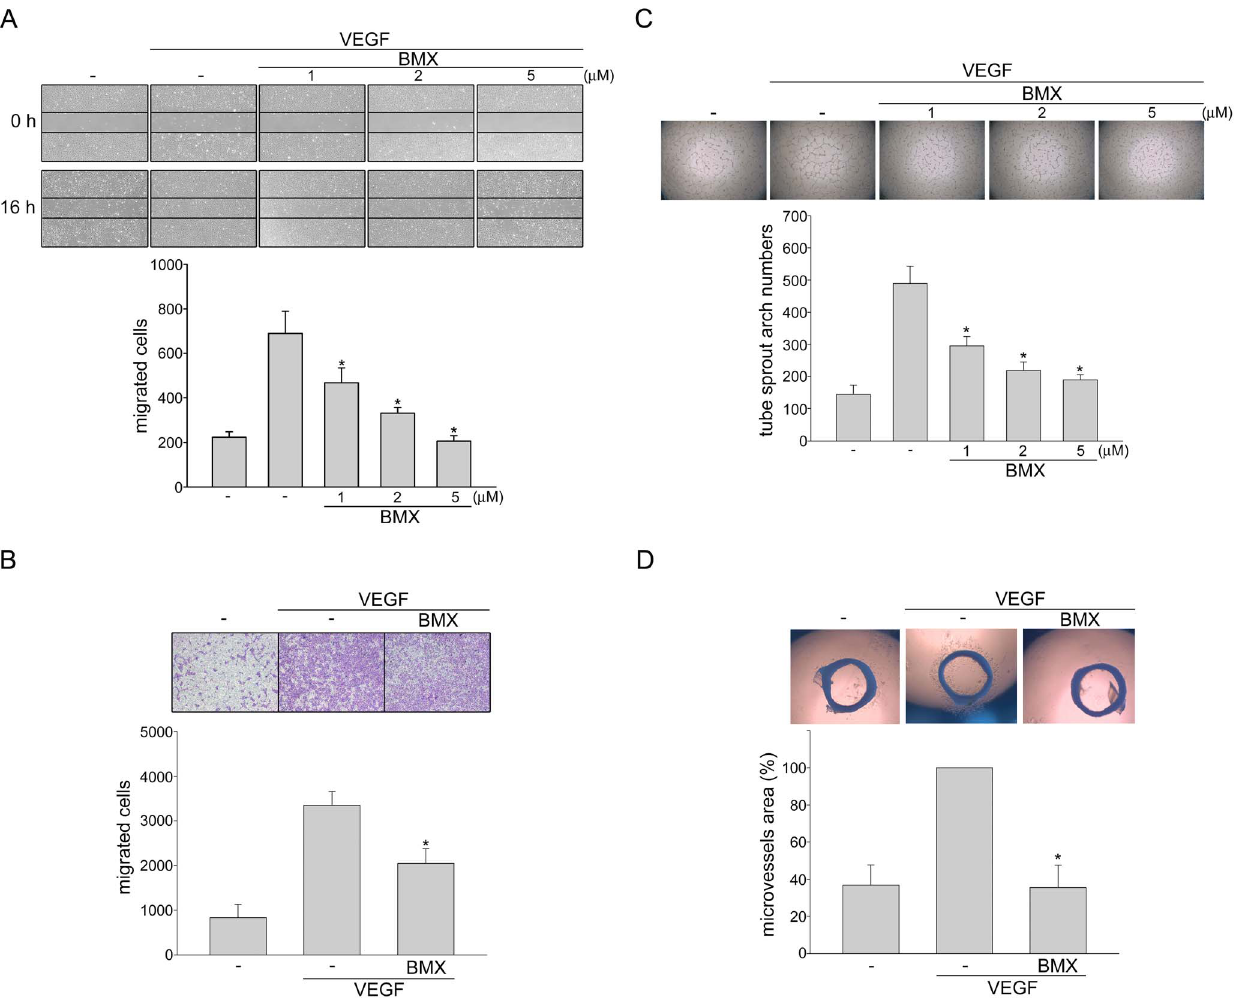
Figure 3. BMX inhibited VEGF-induced migration, tube formation and microvessel sprouting. (A) HUVECs were starved in 2% FBS containing medium without ECGS for 16 h. Cell monolayer were then scratched and treated with vehicle or indicated concentrations of BMX in the presence of VEGF for another 16 h. The number of migrated cells was then determined. Each column represents the mean 6 S.E.M. of four independent experiments. * p , 0.05, compared with the group treated with VEGF alone. (B) After starvation as described in (A), Cells were then seeded in the top chamber in the absence or presence of BMX (5 m M) using VEGF as chemo-attractant. After 16 h, invaded cells through the gelatin- coated membrane were stained and quantified. Each column represents the mean 6 S.E.M. of four independent experiments. * p , 0.05, compared with the group treated with VEGF alone. (C) HUVECs were seeded on Matrigel in the presence of VEGF (20 ng/ml) with or without BMX at indicated concentrations. Cells were then photographed under phase-contrast microscopy after 16 h. Bar graphs show compiled data of average sprout arch numbers (n=4). * p , 0.05, compared with the group treated with VEGF alone. (D) Rat aortic rings were placed in Matrigel and treated with VEGF (20 ng/ml) in the presence or absence of BMX (5 m M). The effect of BMX on formation of vessel sprout from various aorta samples was examined on day 8. Bar graphs show compiled data of average microvessels area (n=4). * p , 0.05, compared with the group treated with VEGF alone.